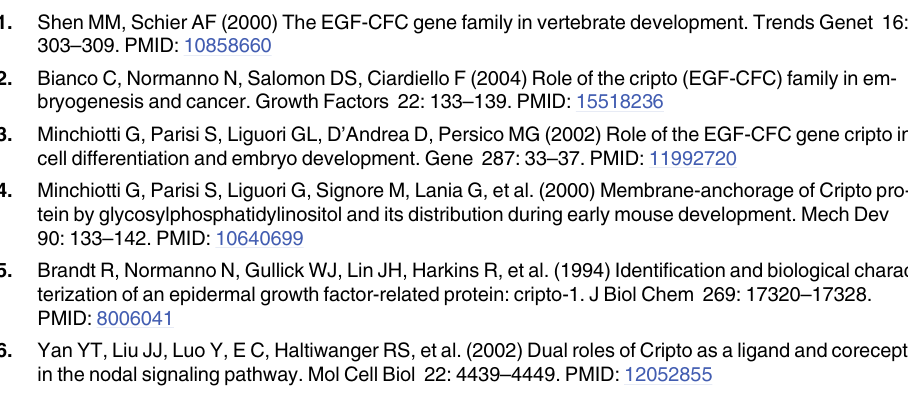
S2 Table. Seed genes analyzed with Ingenuity Pathway Analysis software (IPA) in addition to CRIPTO (TDGF1) gene. S3 Table. Functional annotation sub-categories significantly enriched in genes involved in the network identified by IPA and including CRIPTO